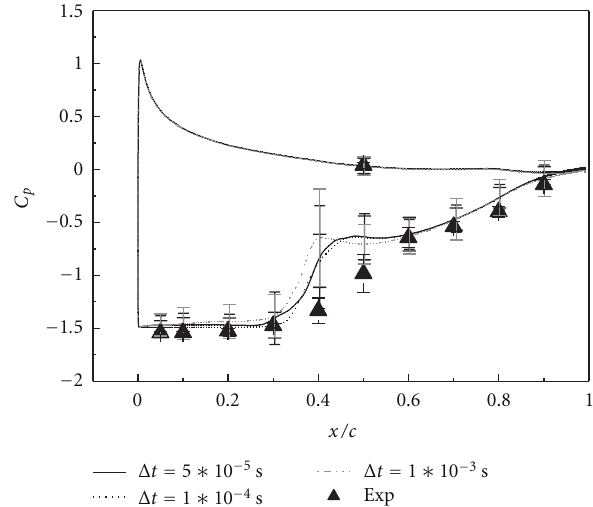
Figure 3: Comparisons of the measured versus predicted pressure coe ffi cients obtained using di ff erent time step sizes, Δ t . The lines represent the mean values and the error bars represent the level of fluctuations. σ = 1 . 49, Re = 750,000, V ∝ = 5m/s, and α = 6 ◦ . Merkle cavitation model, n =